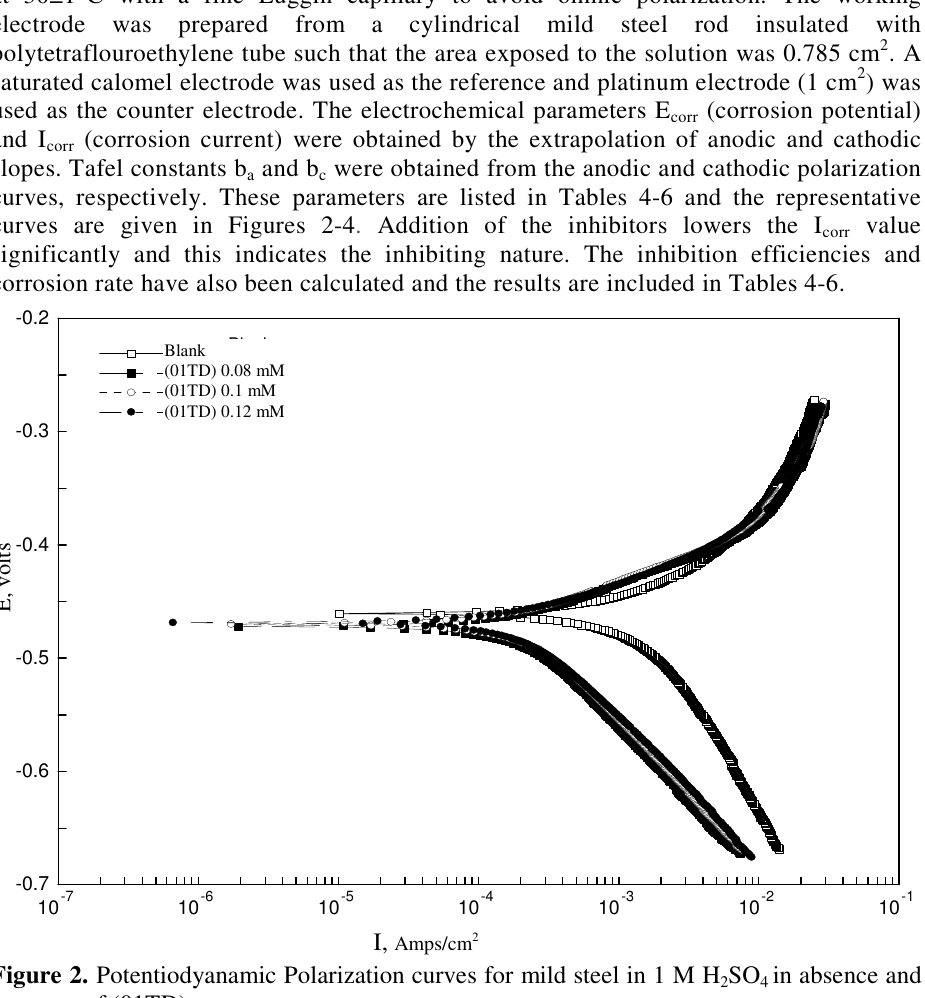
SO in absence and 2 4